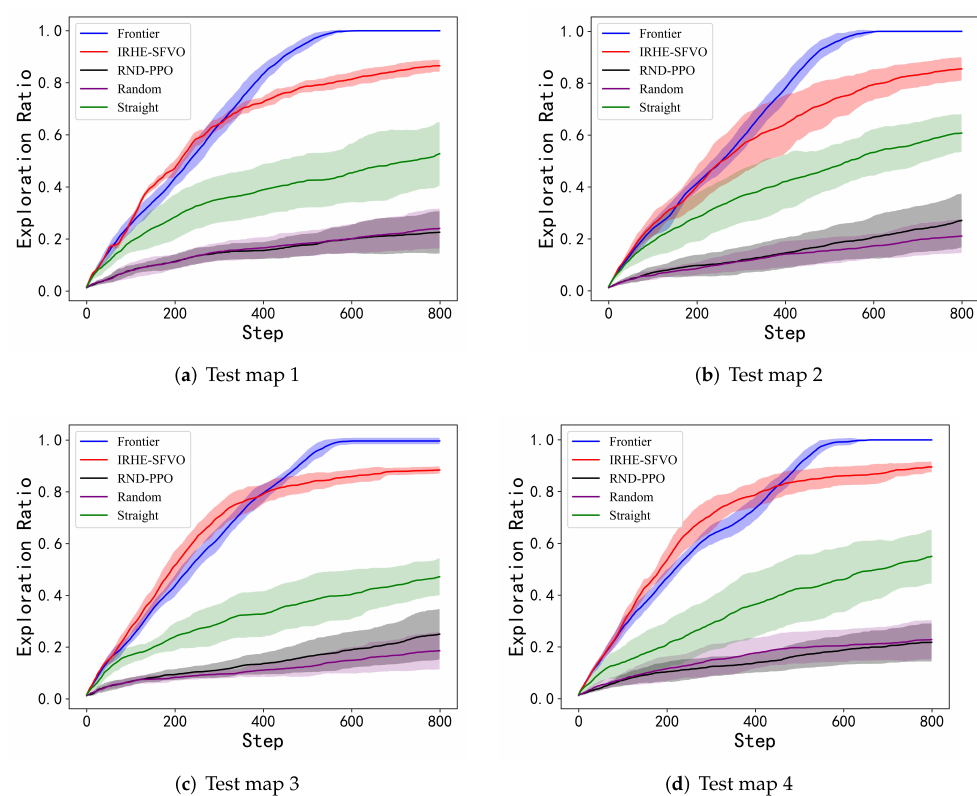
Figure 13. Coverage Performance. Policies are tested in 800 steps (15 random start locations on each of the 4 testing maps). Darker line represents mean exploration ratio and shaded area represents the standard deviation across the 15